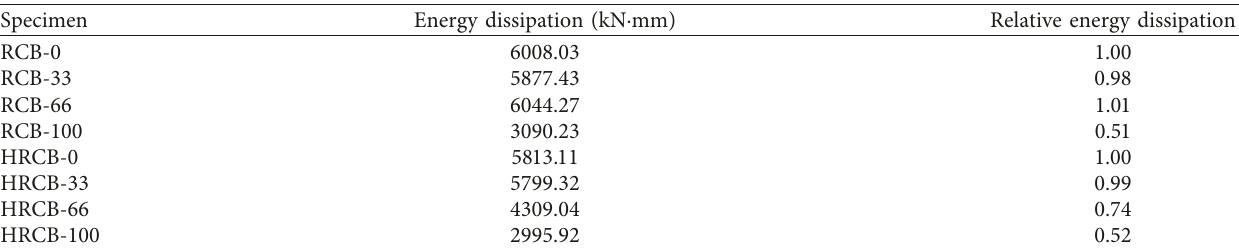
Figure 11: Skeleton curves of load deflection: (a) middle-strength concrete specimens, (b) high-strength concrete specimens, and (c) all specimens. Table 5: Experimental results of energy dissipation.